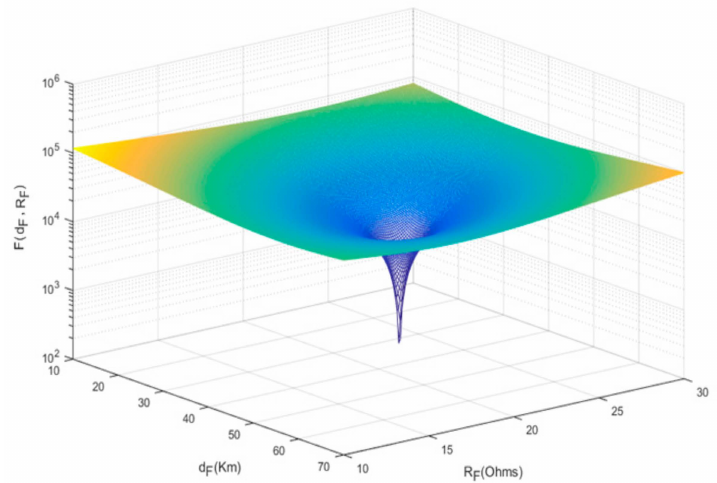
Figure 10. Objective function: fault AG ( d F = 45 km, R F = 20 Ω